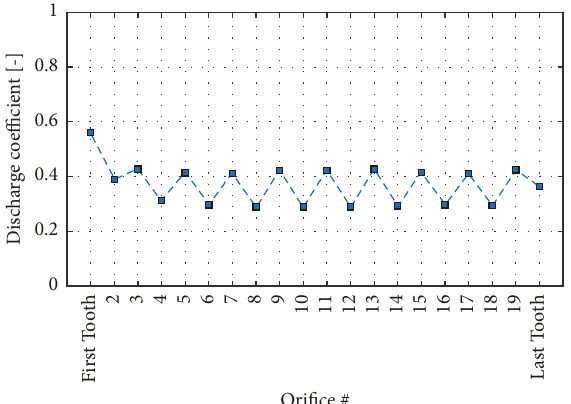
Figure 12: Discharge coefficients in the seal orifice for the test number 4 (seal diameter = 500 mm, pressure drop = 50 bar, inlet preswirl = 1.9, and rotor peripheral velocity = 66.19 m/s).